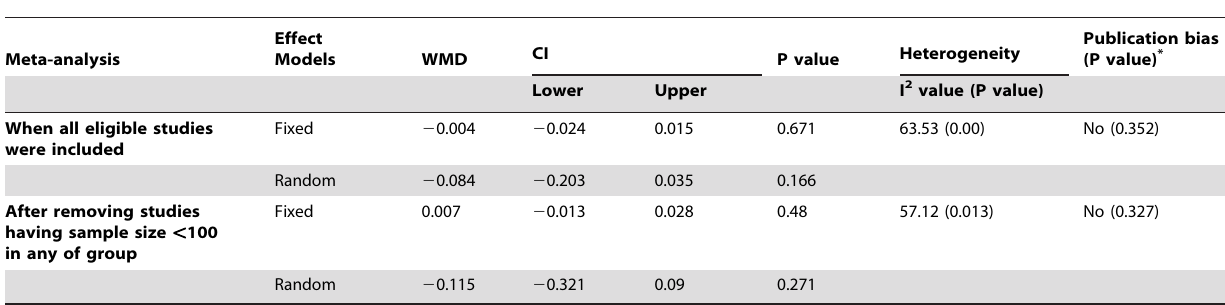
Table 6. Summary of meta-analysis